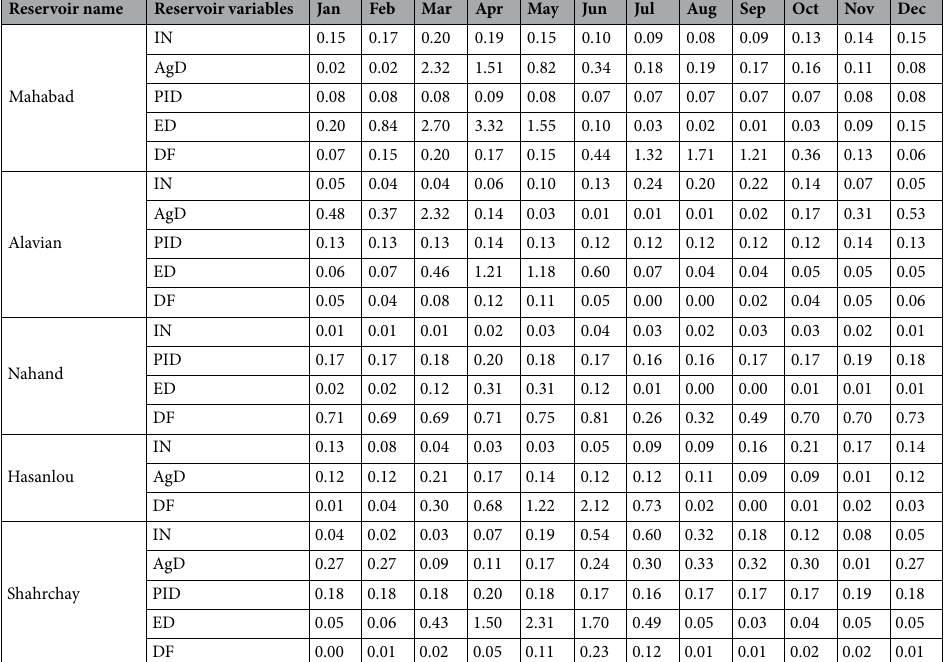
Table 6. Ratios of five variables of five reservoirs to the corresponding values for the Bukan reservoir in the historical period (partially adopted from 22,23 ). IN Inflow; AgD Agricultural water demand; PID Potable and industrial water demand; ED Environmental water demand; DF Downstream